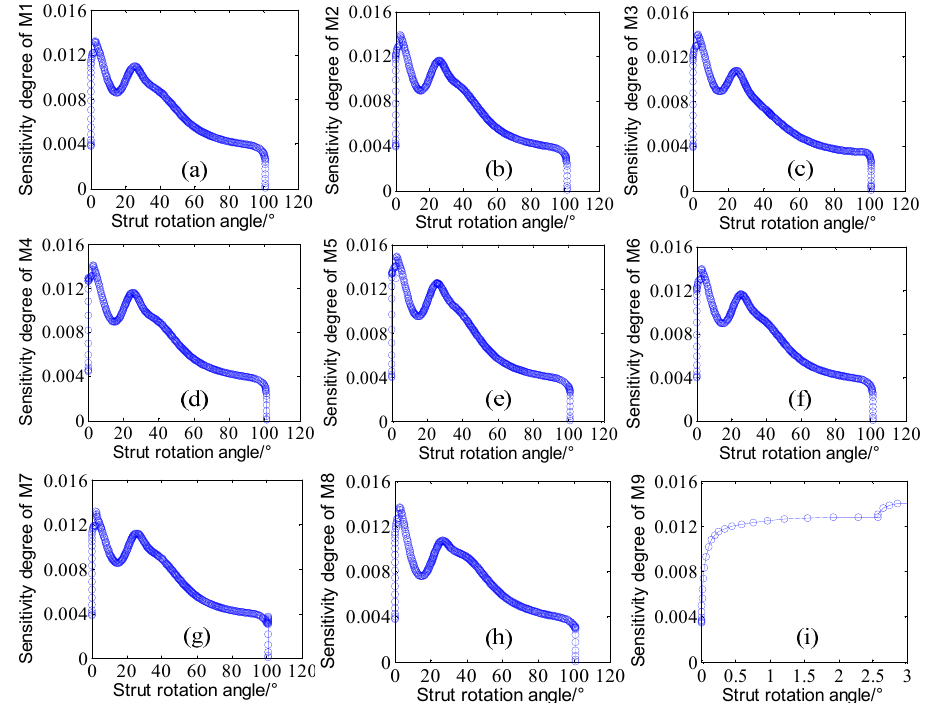
Figure 4. Sensitivities degree of nine torques to strut rotation angle: ( a ) Sensitivity degree of M 1 ; ( b ) Sensitivity degree of M 2 ; ( c ) Sensitivity degree of M 3 ; ( d ) Sensitivity degree of M 4 ; ( e ) Sensitivity degree of M 5 ; ( f ) Sensitivity degree of M 6 ; ( g ) Sensitivity degree of M 7 ; ( h )Sensitivity degree of M 8 ; ( i ) Sensitivity degree of M 9 .